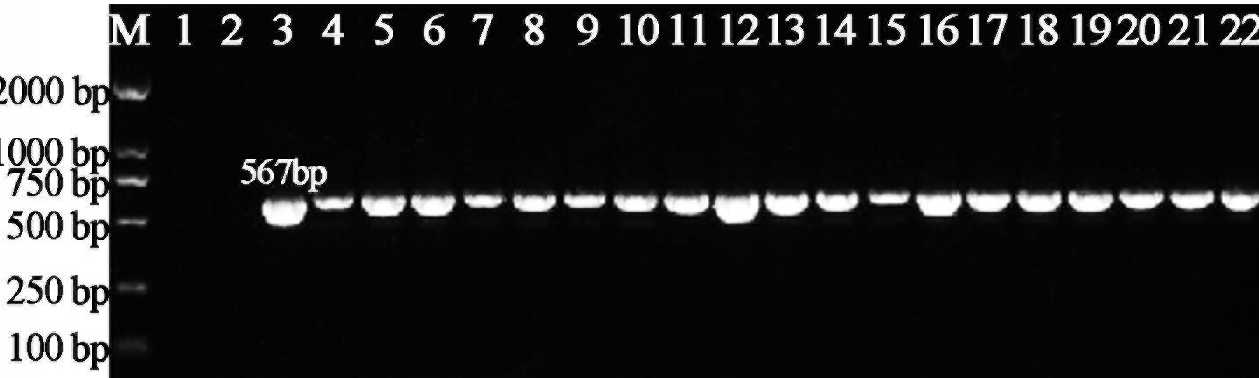
Figure 1. PCR amplification of bacteria from Tn5 mutant library according to the existence of Kan R gene on EZ-Tn5 but not in the wild type of Xanthomonas oryzae pv. oryzae strain C2. M: Maker, DL2000; 1: H 2 O; 2: WT, Wild Type; 3: positive control pRADK; 4~22: Tn5 mutants.